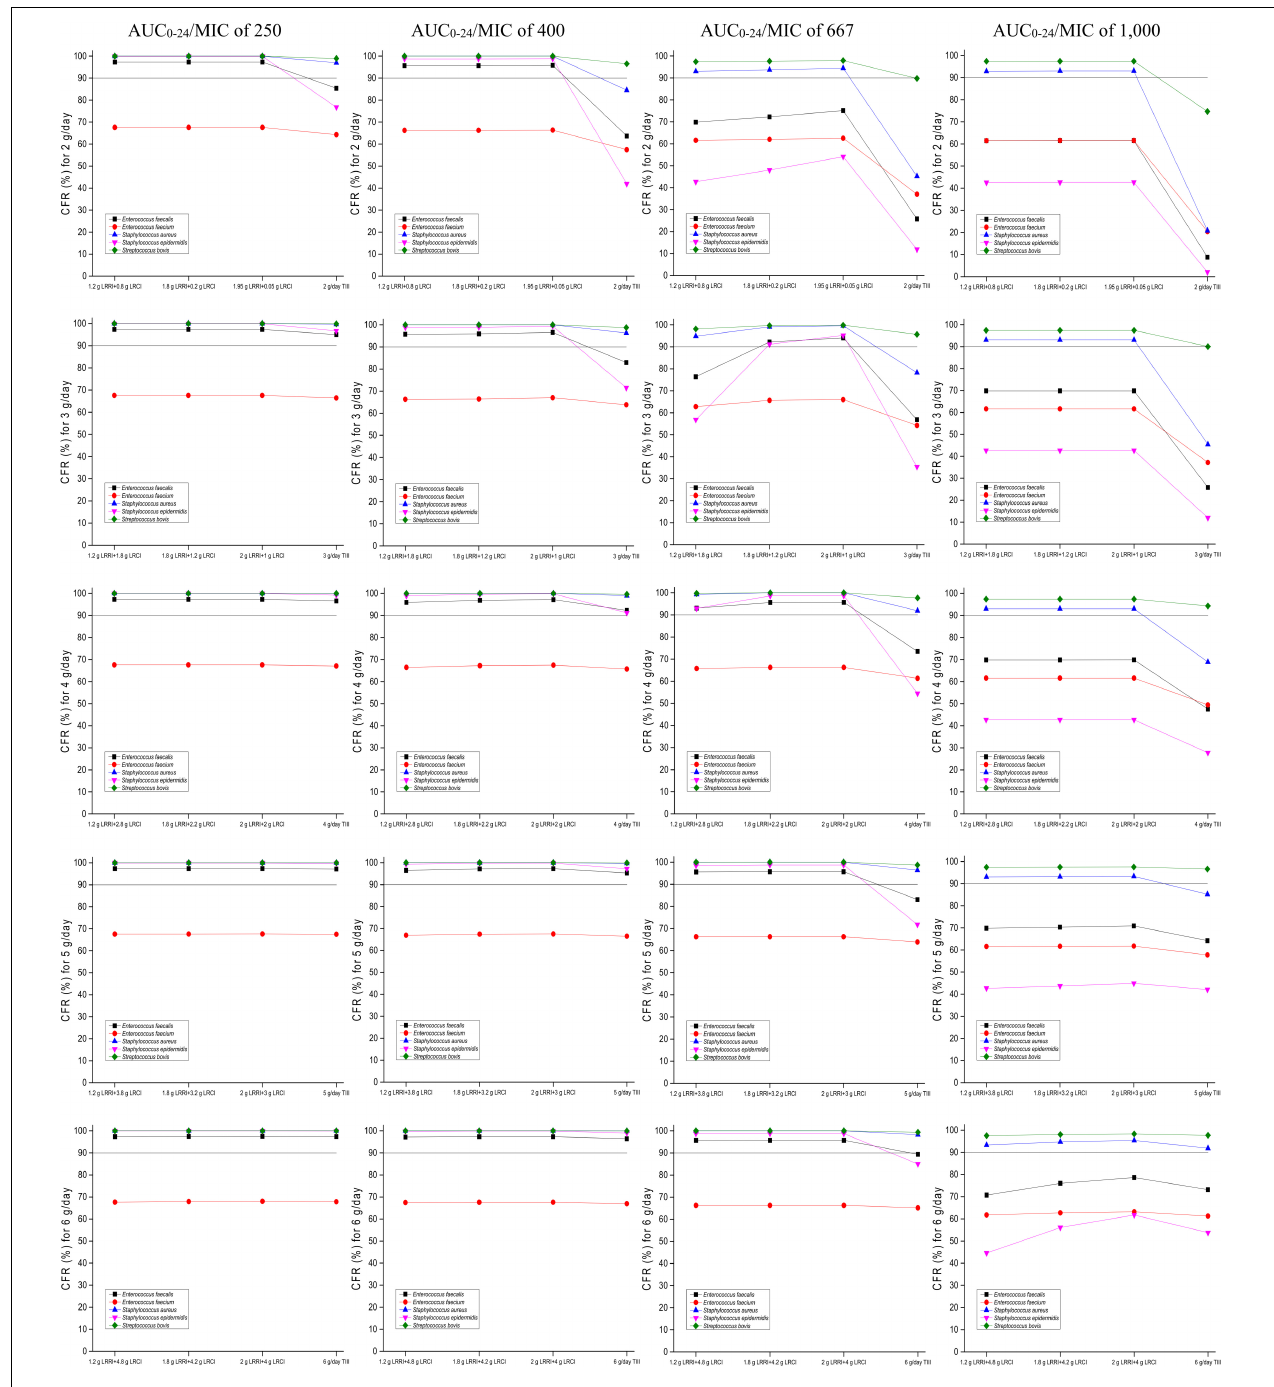
FIGURE 4 | CFRs of achieving AUC 0 − 24 /MIC targets for the targeted bacterial species with pooled MIC distributions. Considering the profiles of VAN tissue penetration, simulating the target AUC 0 − 24 /MIC of 1,000 is for predicting VAN exposure in lung interstitial fluid and cerebrospinal fluid (i.e., for pneumonia and meningitis), 667 is for predicting VAN exposure in sternal bones (i.e., for sternal osteomyelitis), 400 is for predicting VAN exposure in capsular tissue, pleural fluid, and bloodstream (i.e., for mastitis, pleuritis, and bacteremia), and 250 is for predicting VAN exposure in pericardium (i.e., for bacterial